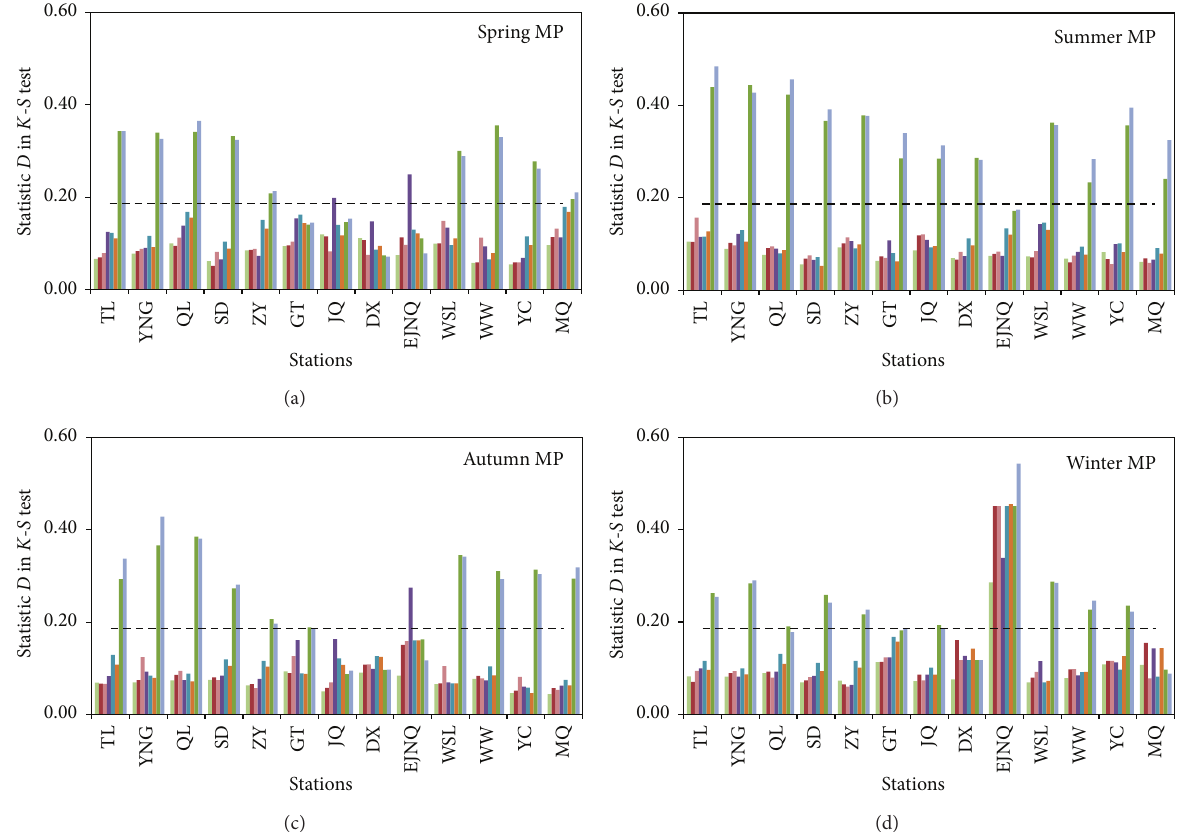
Figure 4: Values of statistic 𝐷 in K-S test for seasonal maximum precipitation of all stations by using different distributions.